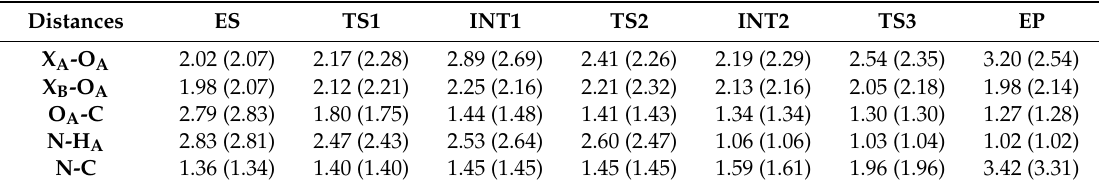
Table 4. Geometrical parameters obtained for the isolated stationary point along the reaction mechanism of Co 2 + -Co 2 + arginase and Mn 2 + -Mn 2 + arginase (in parenthesis) [150,151]. All values are in Å. Distances ES TS1 INT1 TS2 INT2 TS3